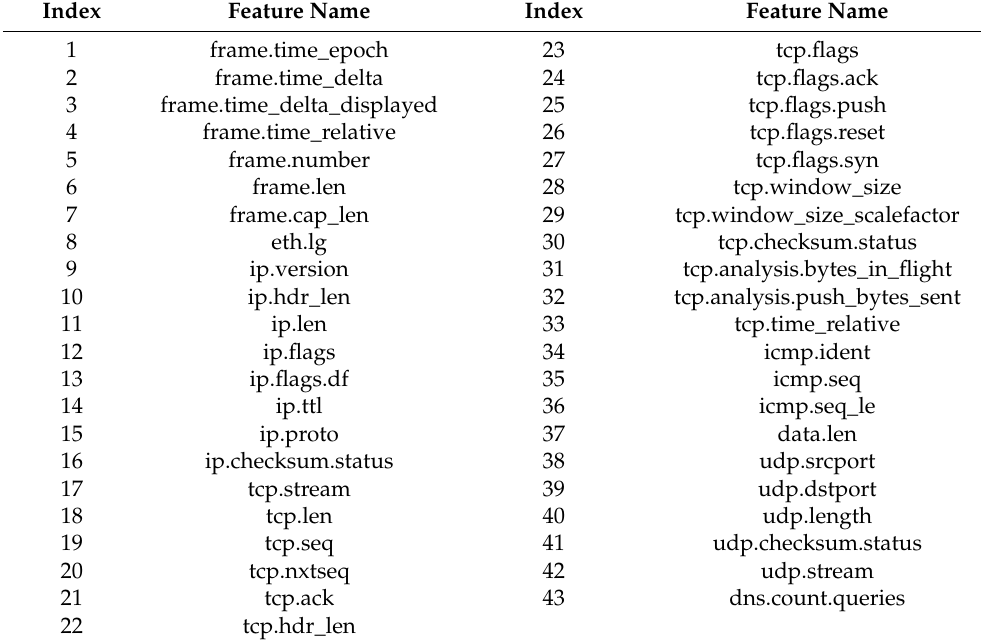
Table 2. Selected characteristic index.